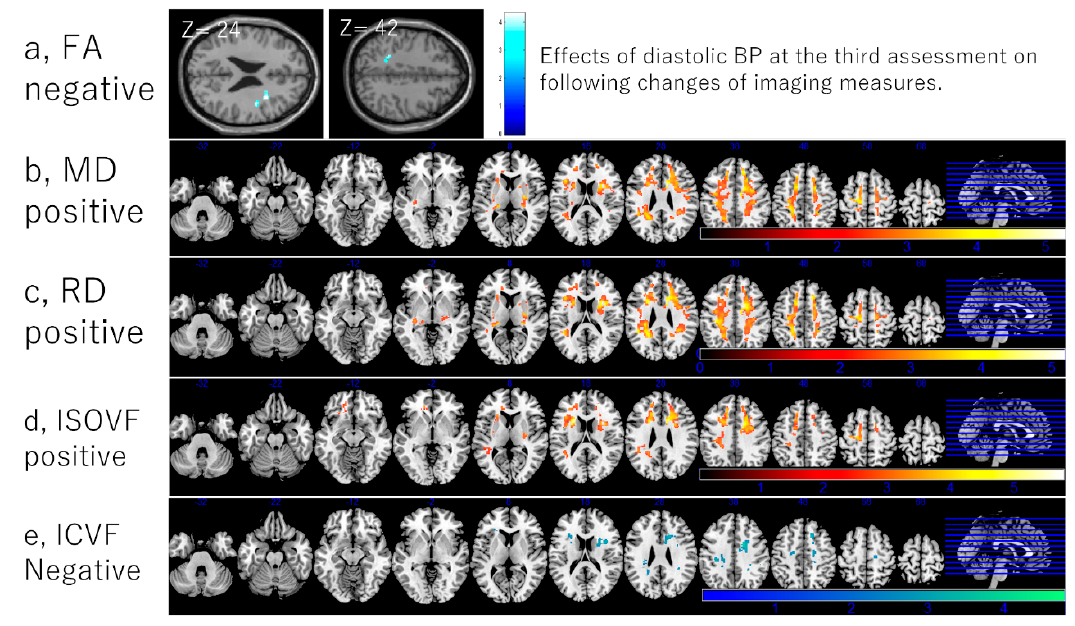
Figure 4. Associations between diastolic BP and subsequent longitudinal changes in brain imaging measures. Associations between a greater diastolic BP and a ( a ) greater FA decline, ( b ) greater MD increase, ( c ) greater RD increase, ( d ) greater ICVF decline, and ( e ) greater ISOVF increase. Results are shown with a threshold p < 0.05 and corrections for multiple comparisons in cluster size tests with a voxel-level cluster-determining threshold p < 0.05 (corrected for FDR). The color represents the strength of the T-value. ( a ) The findings are overlaid on a “single-subject T1” SPM5 image. ( b – e ) Areas of significant associations are overlaid on a “ch2bet” image using MRIcron (https://www.nitrc.org/projects/mricron , accessed on 5 December 2021) and in slices (from the left) of z = − 32, − 22, − 12, − 2, 8, 18, 28 38, 48, 58, and 68.